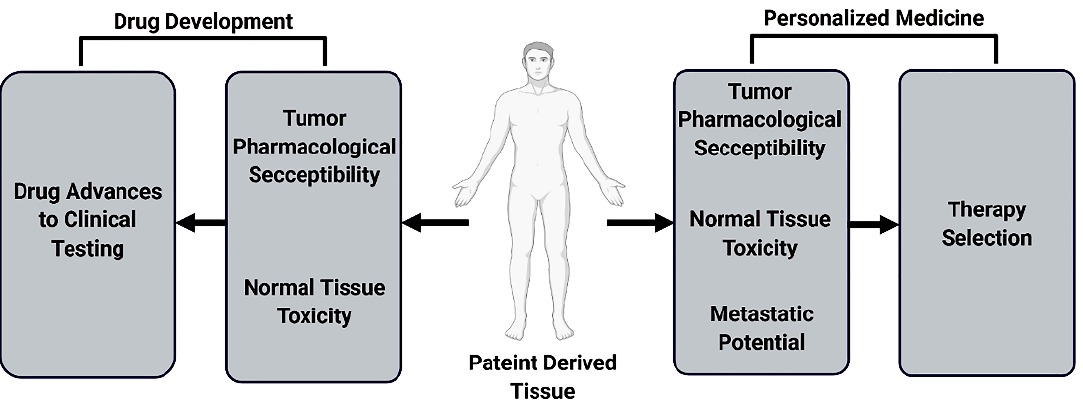
Figure 4. Patient-derived organoids have a significant role in drug screening, validation, development, and in personalized medicine. On a high throughput scale, biobank organoids can capture a wide swath of diversity for pharmaceutical development. On the individual level, paired organoid studies could help guide therapeutic selection.